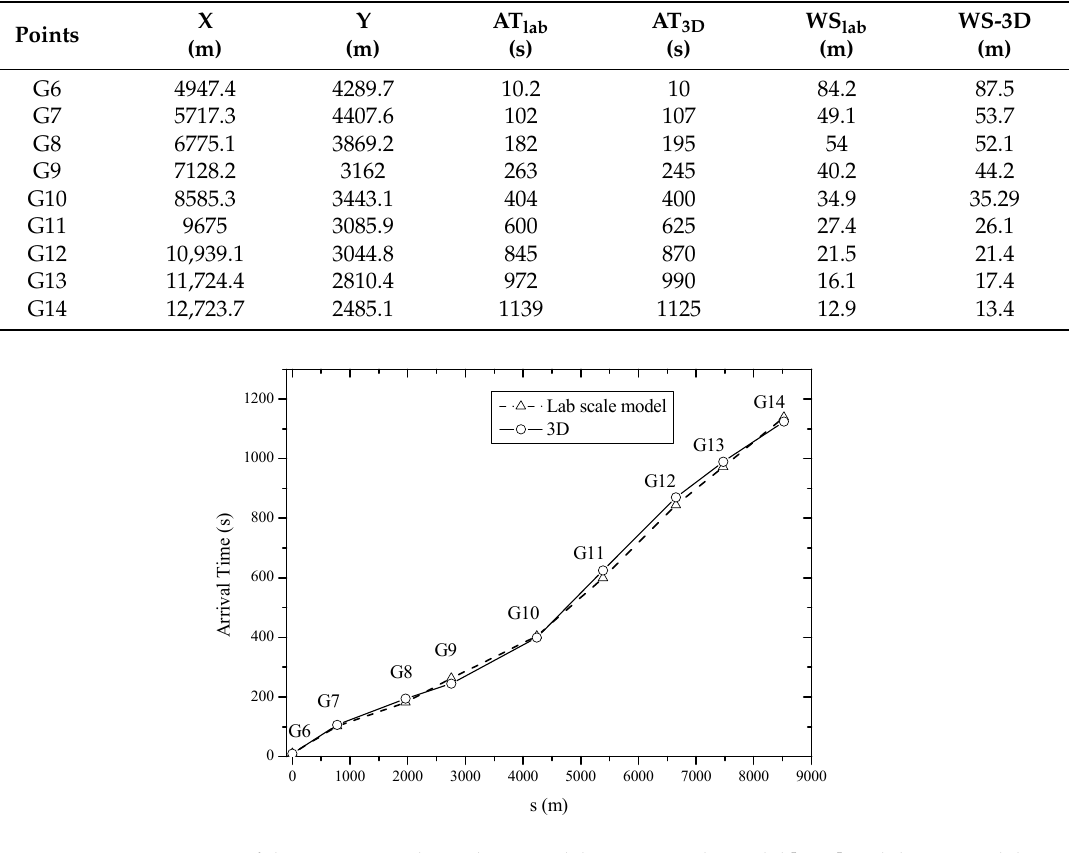
Figure 5. Flooded area at different time steps after dam break.